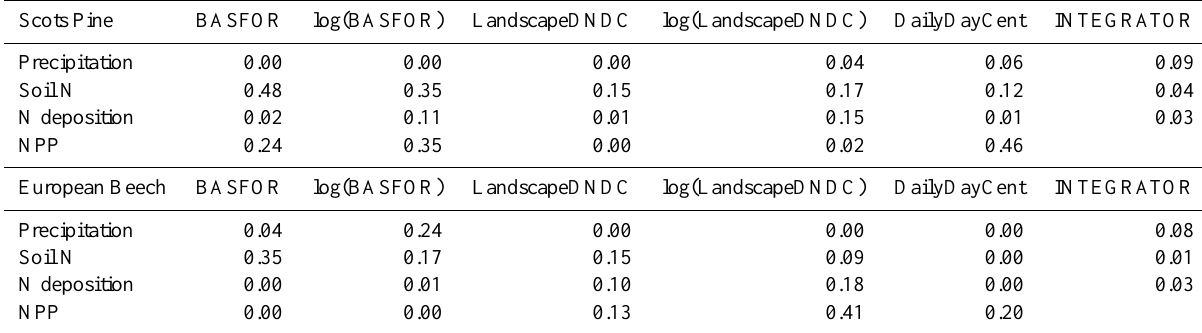
Table 3. R 2 of linear regressions for N 2 O and the logarithm of N 2 O of Scots pine and European beech forests. Scots